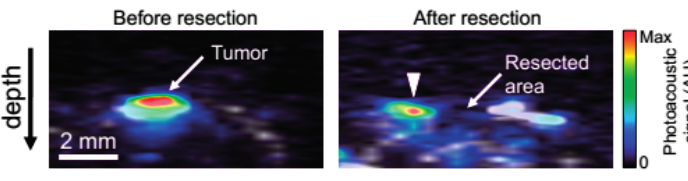
Figure 7. Intra-operative Photoacoustic imaging. A mouse bearing a glioblastoma tumor (primary human xenograft) was injected with MPRs (150 µL, 16 nM). After 24 h, the brain was perfused with PBS, excised, and embedded in an agarose gel. Coronal photoacoustic images were acquired before ( left image) and after ( right image) partial tumor resection. An absence of photoacoustic signal in the resected portion of the tumor was observed, while residual photoacoustic signal (arrow-head) was observed in the area of the non-resected tumor. Note that the increased grayscale ultrasound signal to the right of the resected cavity is likely due the surgical manipulation, an effect that is commonly observed during surgery. Photoacoustic images (color scale from 0 to max) were overlaid on conventional ultrasound images (gray), which outline the gross anatomy of the mouse brain. (Reprinted from reference